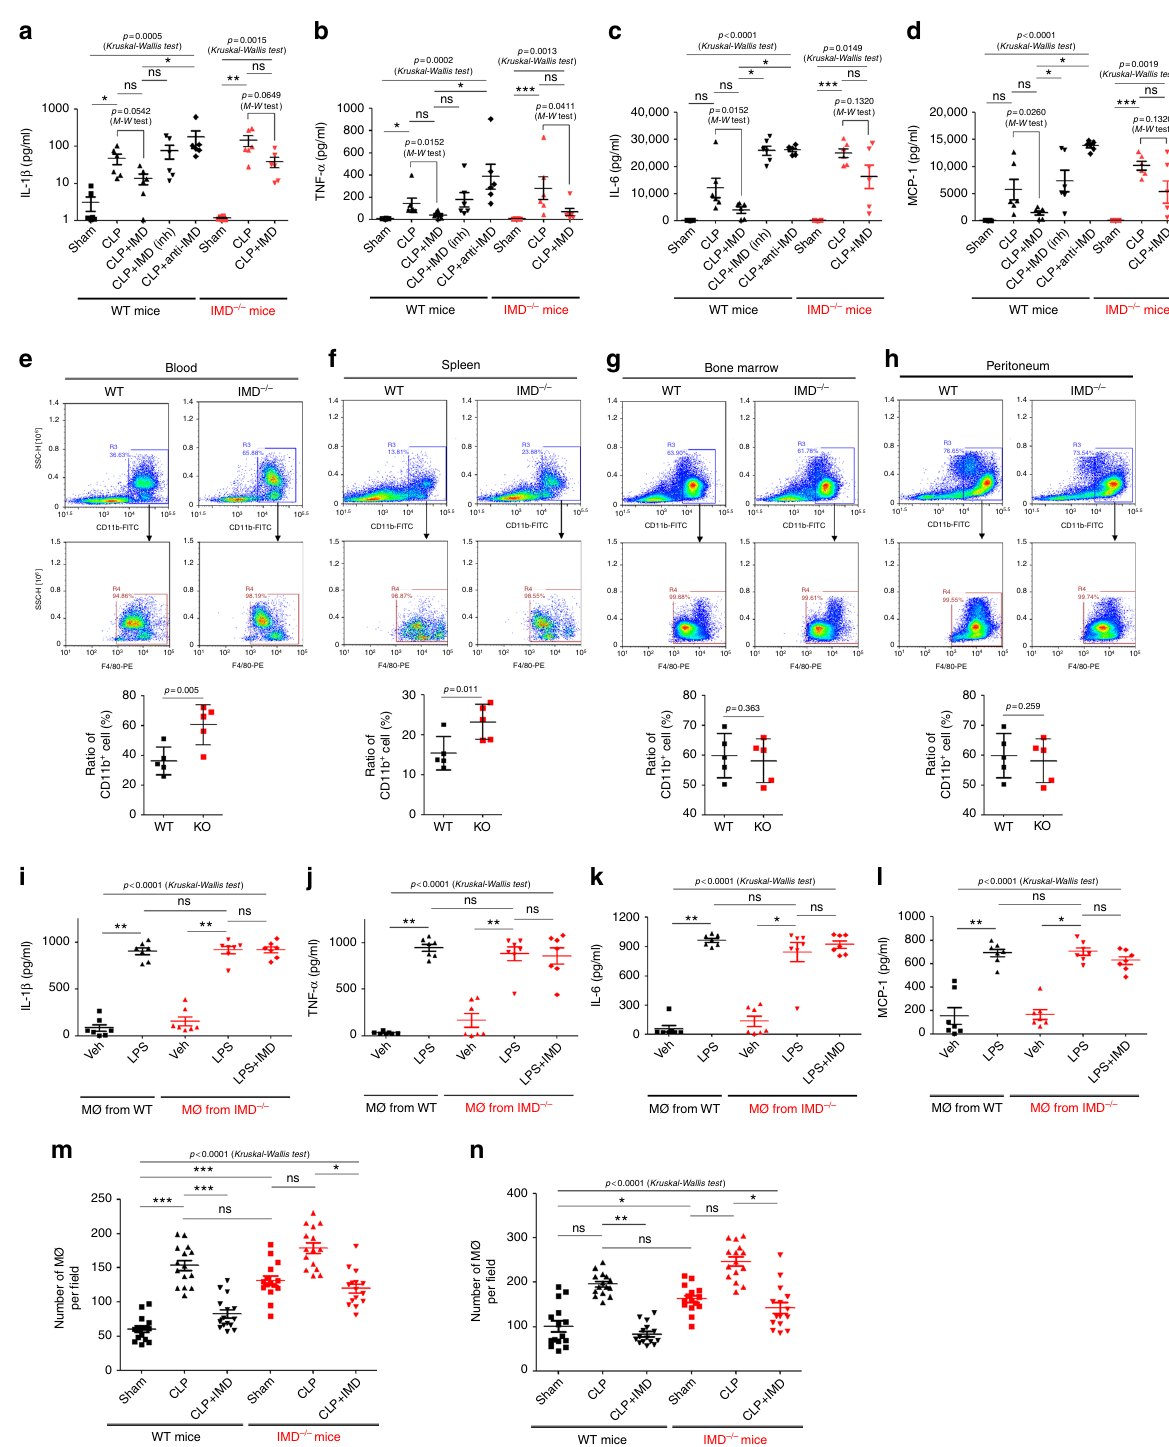
Fig. 4 IMD ameliorated the in fl ammatory response. a – d IMD 40 (0.5 mg/kg), or IMD inh (1 mg/kg), or anti-IMD mAb (2.5 mg/kg) was injected into WT or IMD − / − mice 1 h before CLP or sham surgery. The blood samples were harvested 9 h after surgery. The concentration of IL-1 β ( a ), IL-6 ( b ), TNF- α ( c ), and MCP ( d ) was determined by ELISA. e – h The macrophage pro fi le on steady state of blood, spleen, bone marrow, and peritoneum. Gating strategy: using CD11b and F4/80 to identify the macrophage. The lowest panels: the macrophage pro fi le (%) was presented as scatter plots with mean ± SEM ( n = 5 mice). i – l The peritoneal macrophages were isolated from WT or IMD − / − mice, and tested for cytokine productions after the stimulation of LPS. m, n The macrophage in fi ltration in liver and lung 9 h after surgery was quanti fi ed. Number of macrophages per fi eld was presented as scatter plots with mean ± SEM using 15 randomly chosen fi elds from three mice. Signi fi cance was assessed by Mann – Whitney test (e-h) or Kruskal – Wallis test followed by non- parametric Dunn ’ s post-hoc analysis (a – d, m,